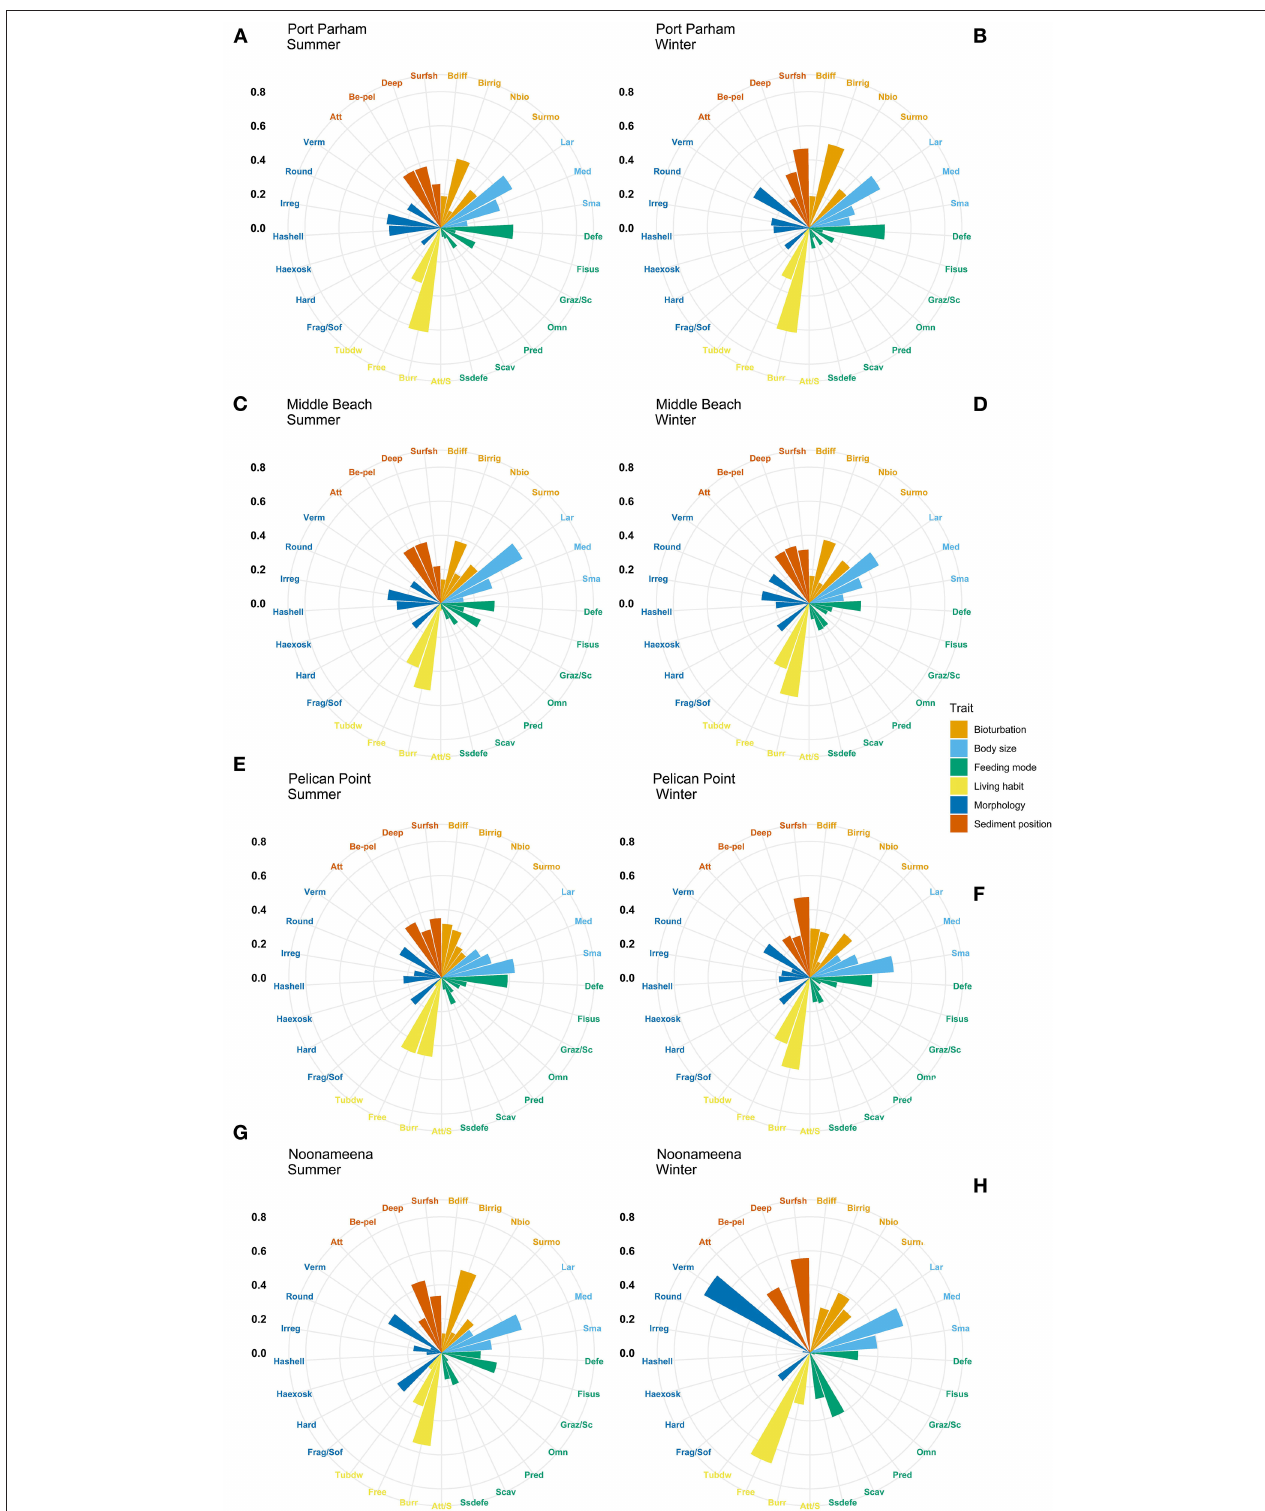
FIGURE 5 | Community-weighted means (CWM) of trait-modalities expression. Scale represents the percentage contribution to CWM. Trait modalities labels (acronyms) are defined in Table 2. Port Parham (A) summer, (B) winter; Middle Beach (C) summer, (D) winter; Pelican Point (E) summer, (F) winter; and Noonameena (G) summer, (H)